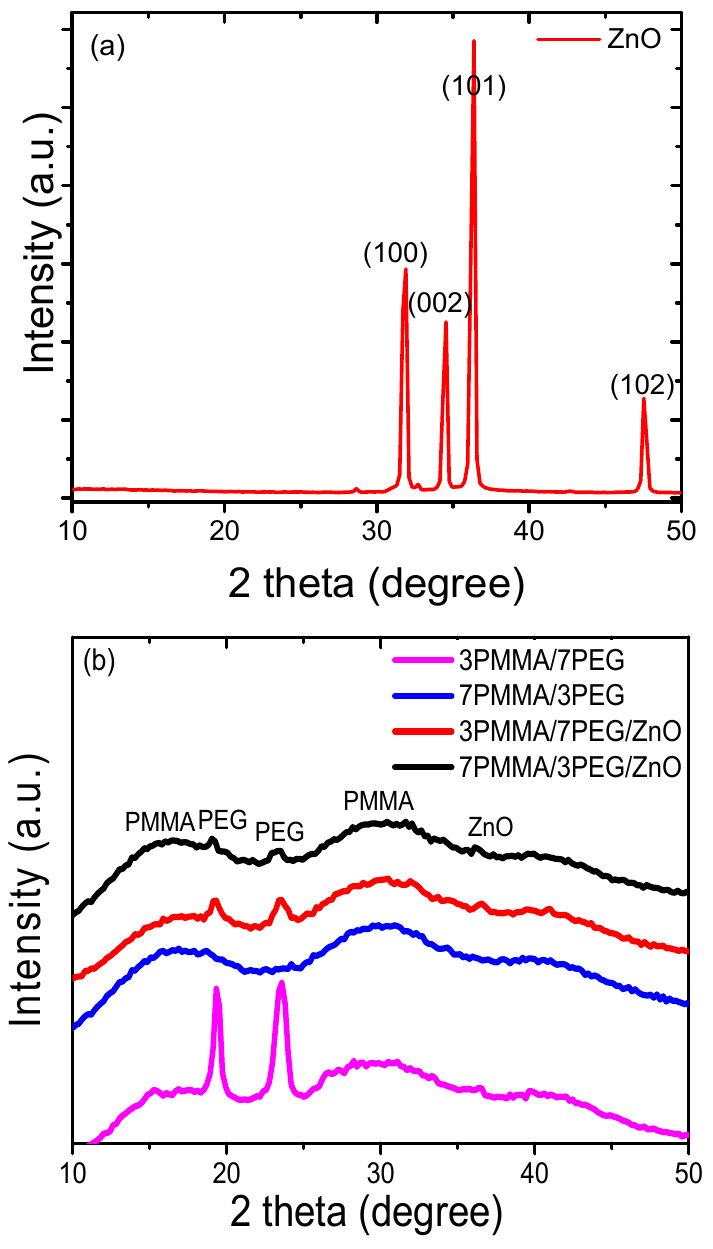
Figure 3. XRD diffraction profiles of: ( a ) ZnO powder, ( b ) polymer blends (7PMMA/3PEG and 3PMMA/7PEG) and nanocomposite blends (7PMMA/3PEG/ZnO and 3PMMA/7PEG/ZnO).